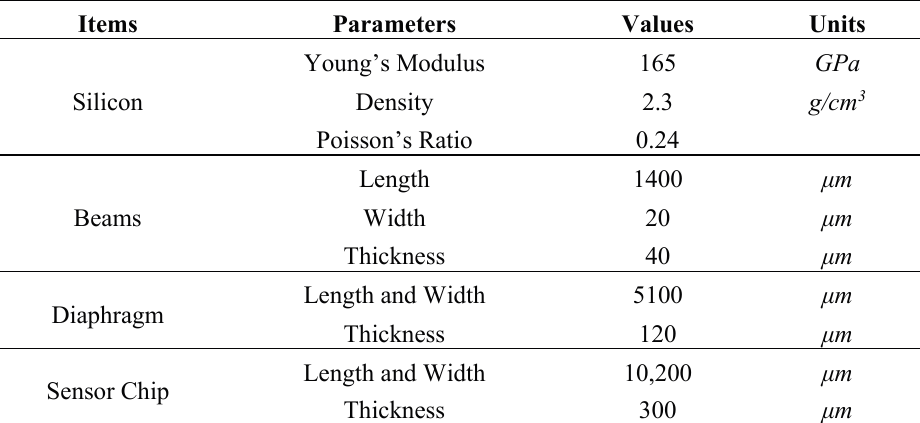
Table 1. Parameter list used in FEM